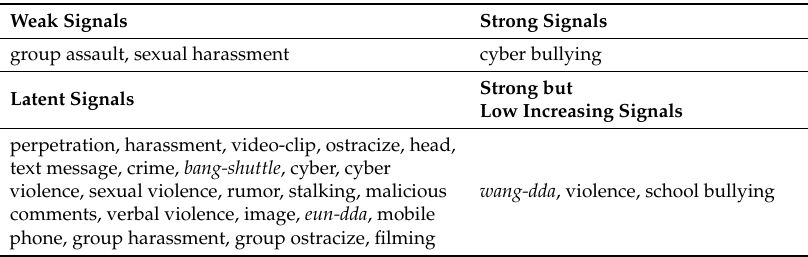
Table 2. Future Signals of school bullying